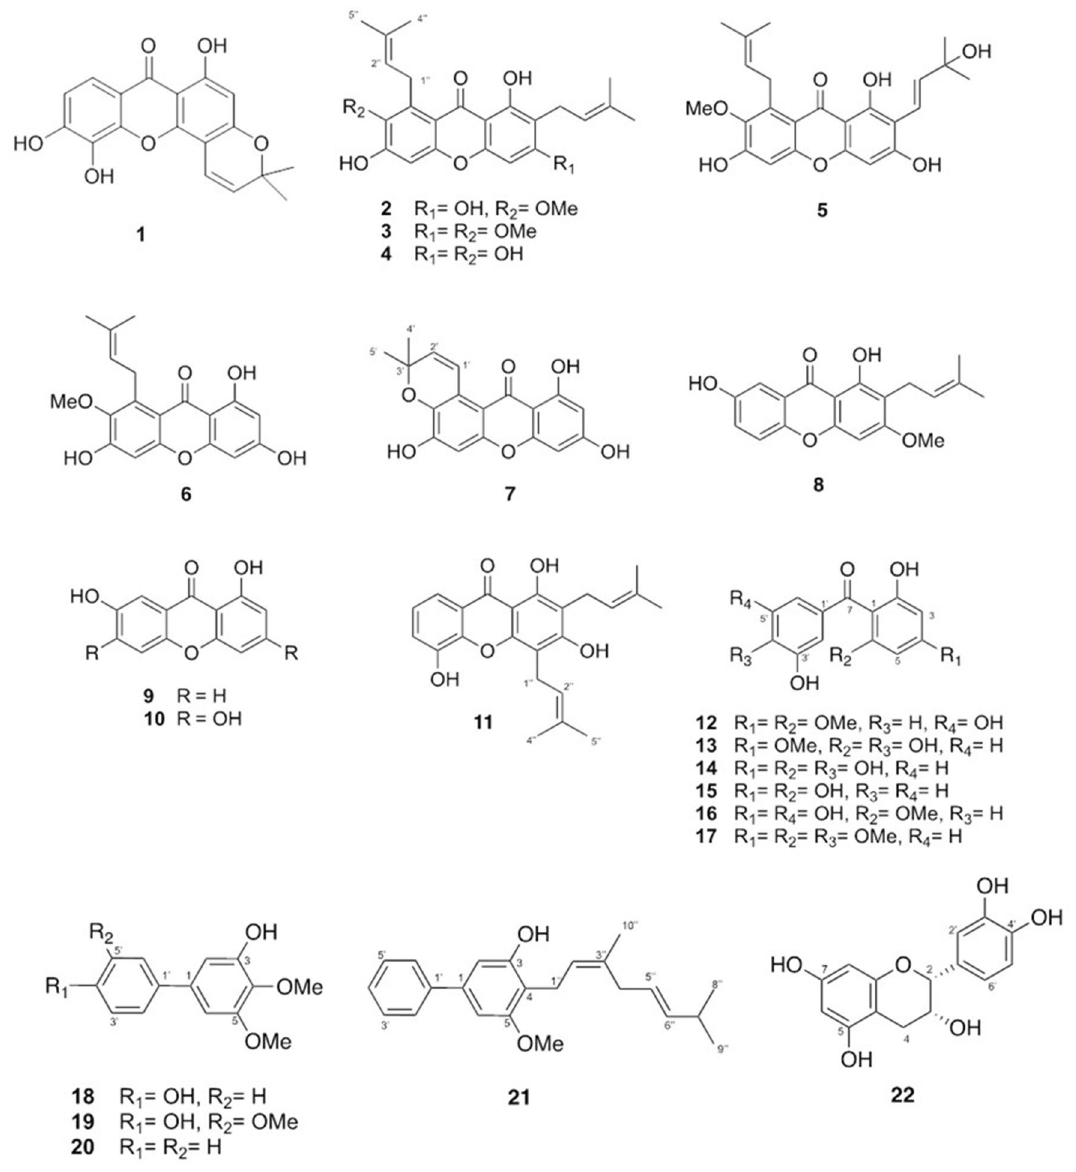
Figure 1. Structures of isolated compounds 1 – 22